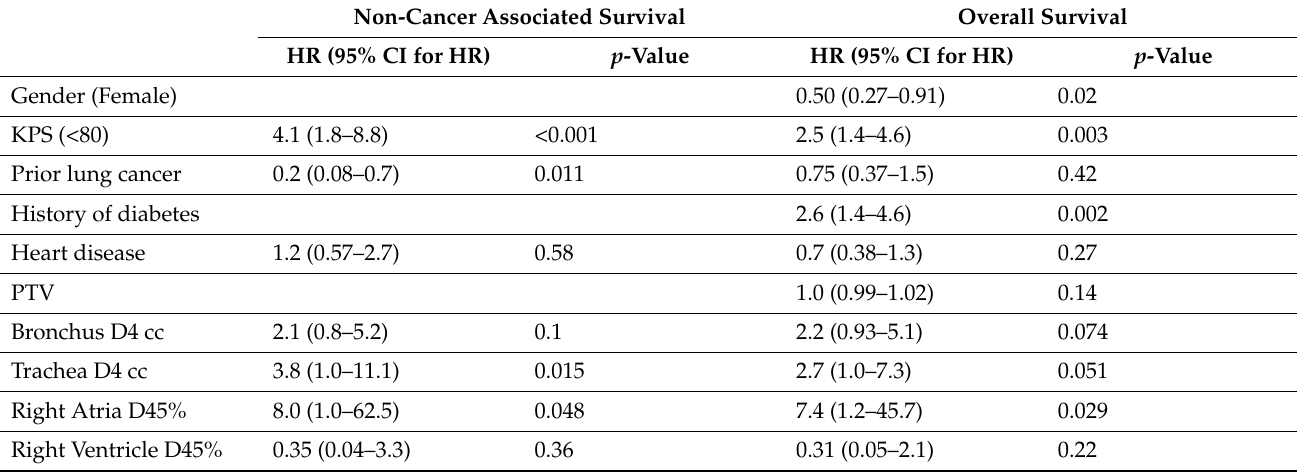
Table 4. Multivariate Cox